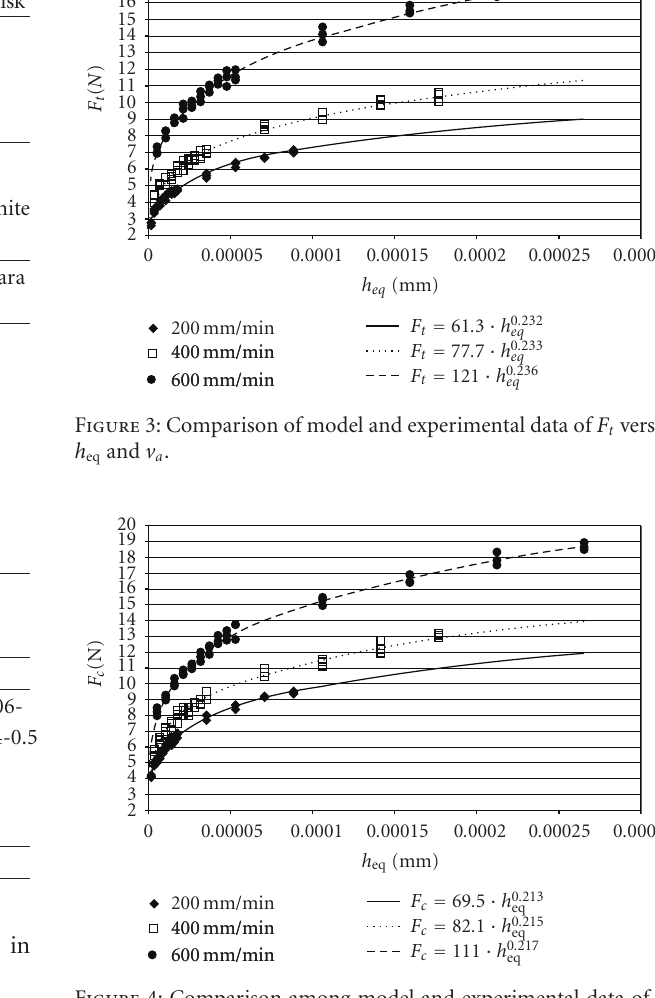
Figure 4: Comparison among model and experimental data of F c versus h eq and v a